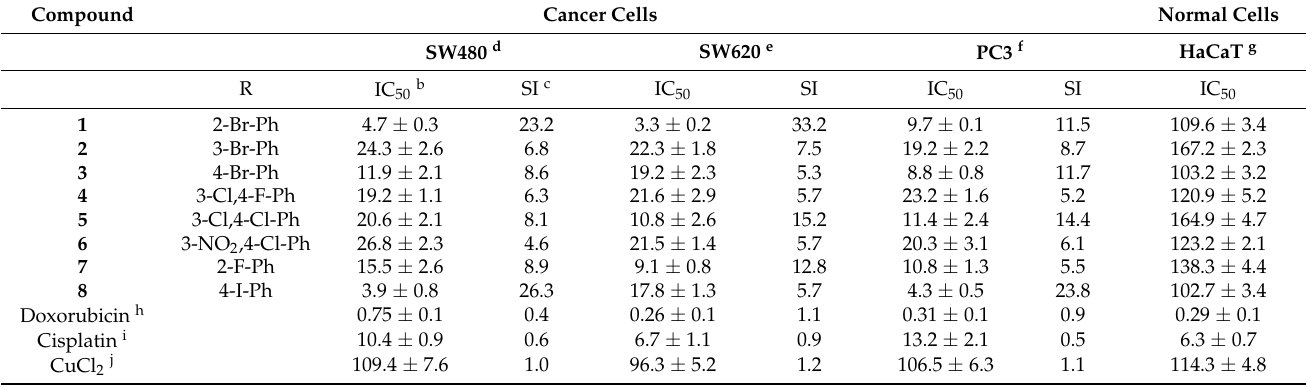
Table 2. Cytotoxic activity (IC 50 , µ M) of studied compounds estimated by the MTT assay a . Compound Cancer Cells Normal Cells SW480 d SW620 e PC3 f HaCaT